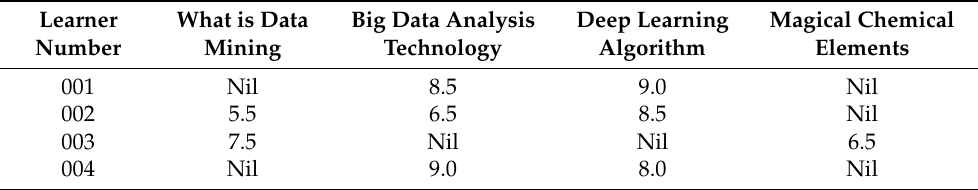
Table 10. Evaluation score table by learners.